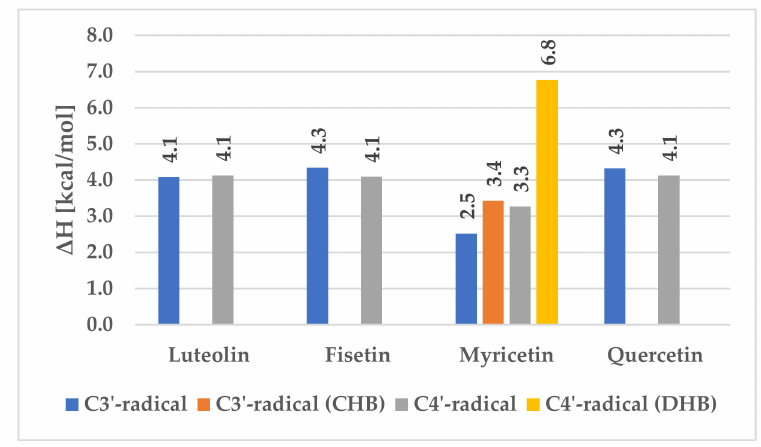
Figure 3. Di ff erences in hydrogen bond